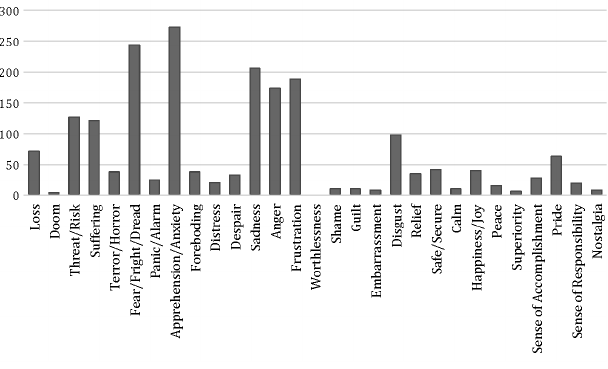
Fig. 2. Total emotion counts from all newspaper articles